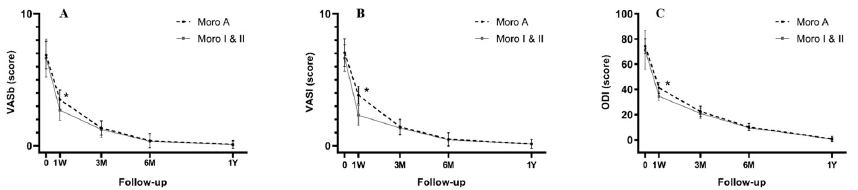
Figure 2. Clinical scores at different follow-up times. The VASb ( A ), VASl ( B ), and ODI ( C ) scores showed worse results in the Moro A group at 1-week postoperative follow-up. *, p < 0.001. Table 4. Pearson correlation analysis between pre-op imaging indicators and post-op clinical out-